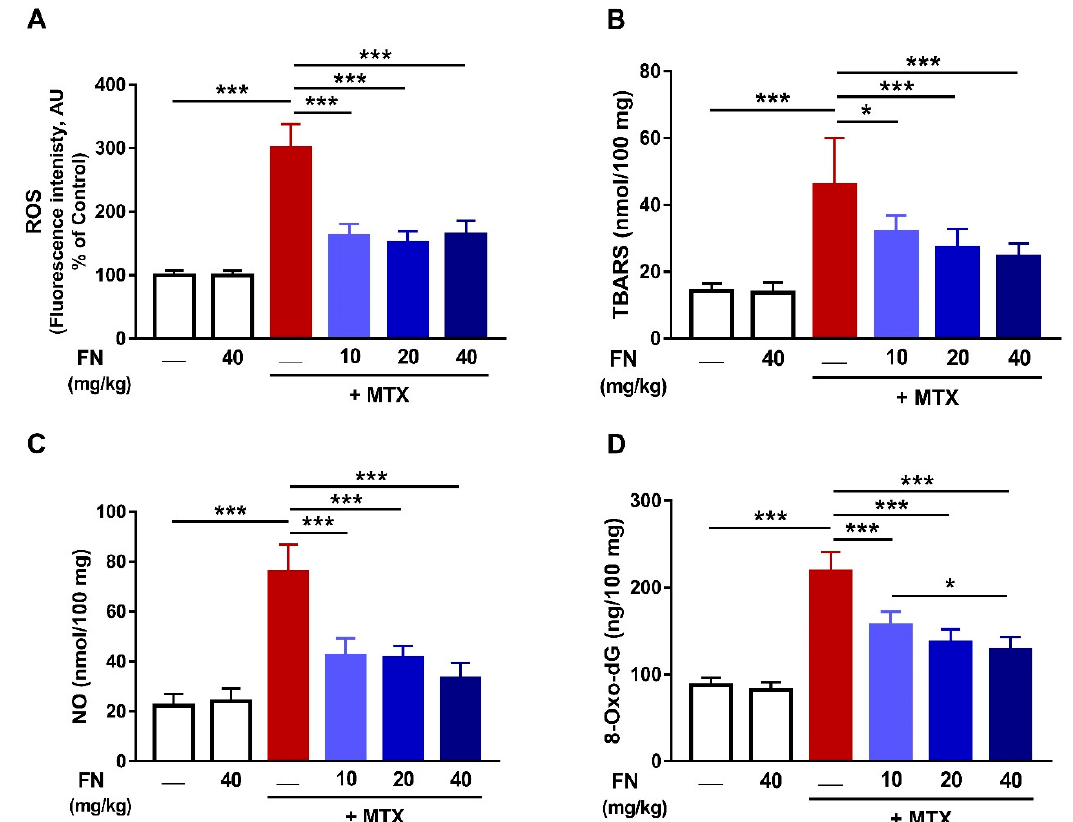
Figure 2. FN prevents oxidative stress and DNA damage in MTX-administered rats. FN reduced reactive oxygen species (ROS) ( A ), thiobarbituric acid reactive species (TBARS) ( B ), nitric oxide (NO) ( C ) and 8-Oxo-2’-deoxyguanosine (8-Oxo-dG) ( D ) in the kidney of rats which received MTX. Data are mean ± SEM, ( n = 6). * p < 0.05 and *** p < 0.001.